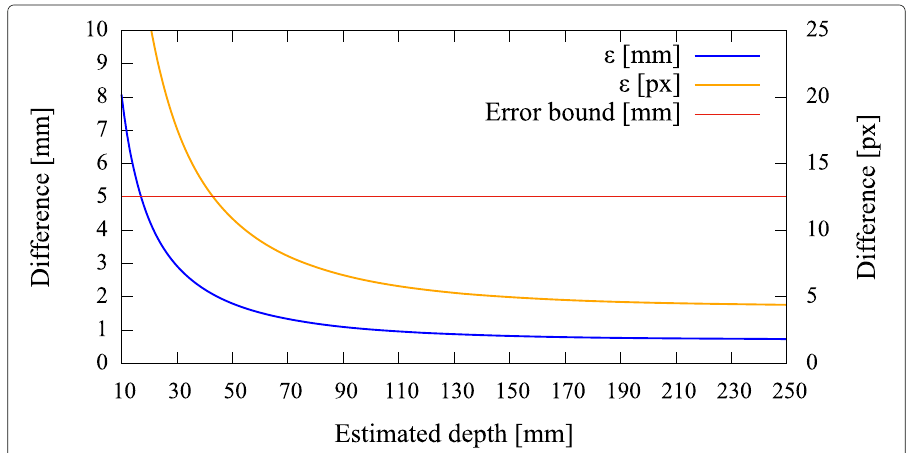
Fig. 14 Pair 1, true source distance 90mm ( x 3 ), initial camera distance 90.8 mm ( x (cid:3) 3 ). The curves (cid:3) ( mm ) , (cid:3) ( px ) indicate that we are below the maximally allowed error in case the stored initial calibration is used (no